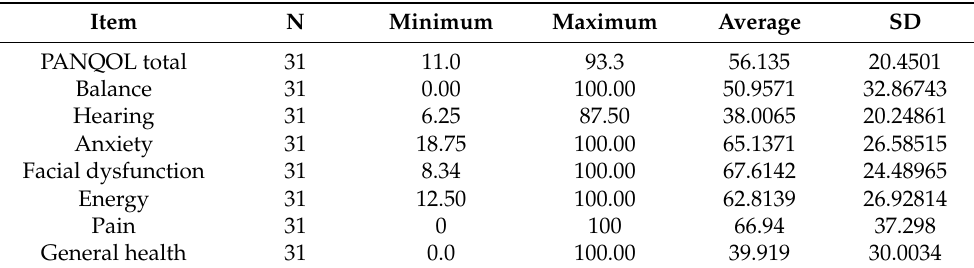
Table 4. Descriptive statistics of PANQOL questionnaire ( n = 31).